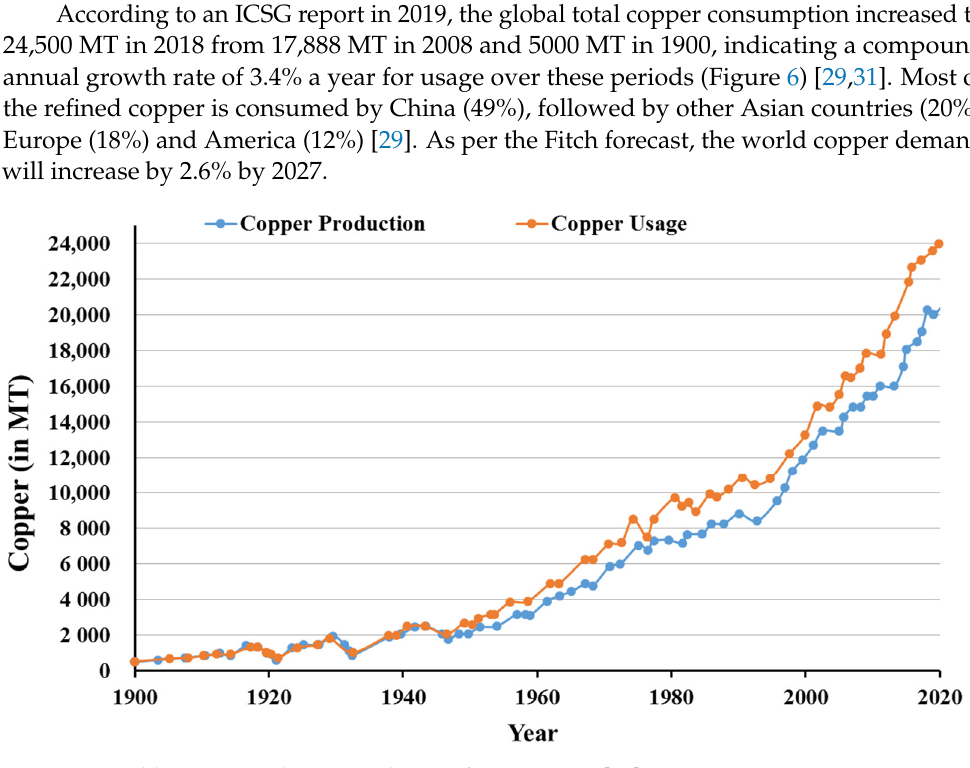
Figure 6. World copper production and usage for 1900–2020 [31].